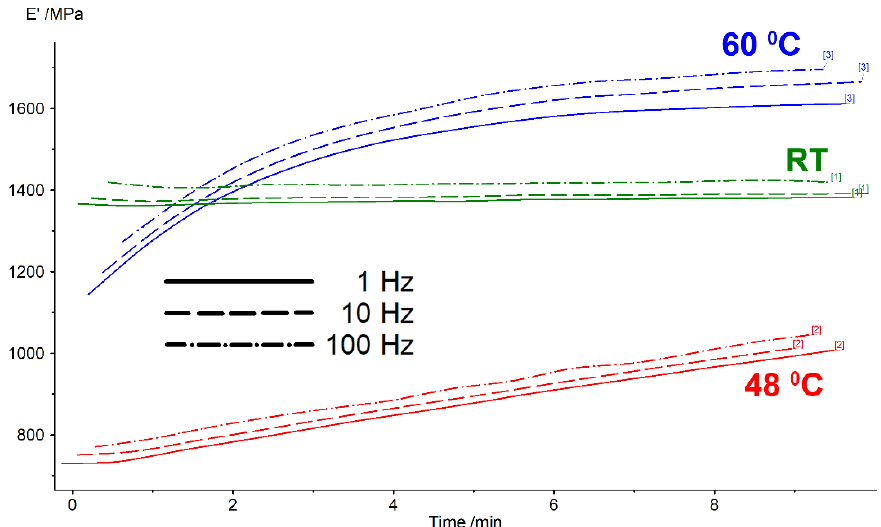
Figure 9. Isothermal DMA diagrams recorded at RT at 48 °C and at 60 °C with 3D printed specimens